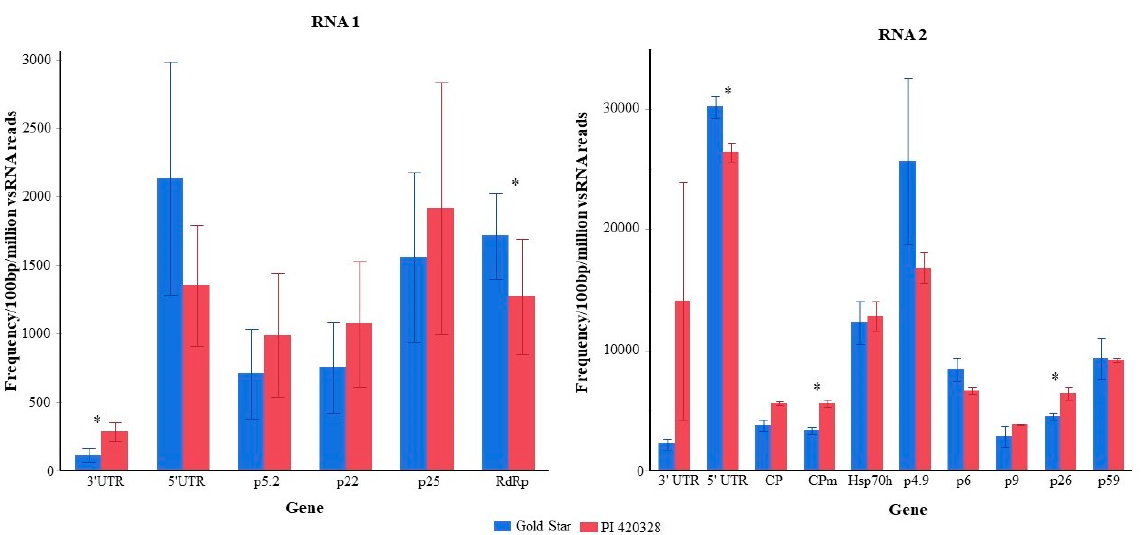
Figure 4. Accumulation of 21–25 nt virus-derived sRNAs corresponding to UTRs and cistrons of CYSDV in Cucurbita pepo leaves at 30 DAI. Values are the average of three biological replicates and are represented as the frequency of vsRNA/100 bp of gene length/million total vsRNA reads. Asterix ( * ) indicates that corresponding values in Gold Star and PI 420328 are significantly different ( t- test, p < 0.05).